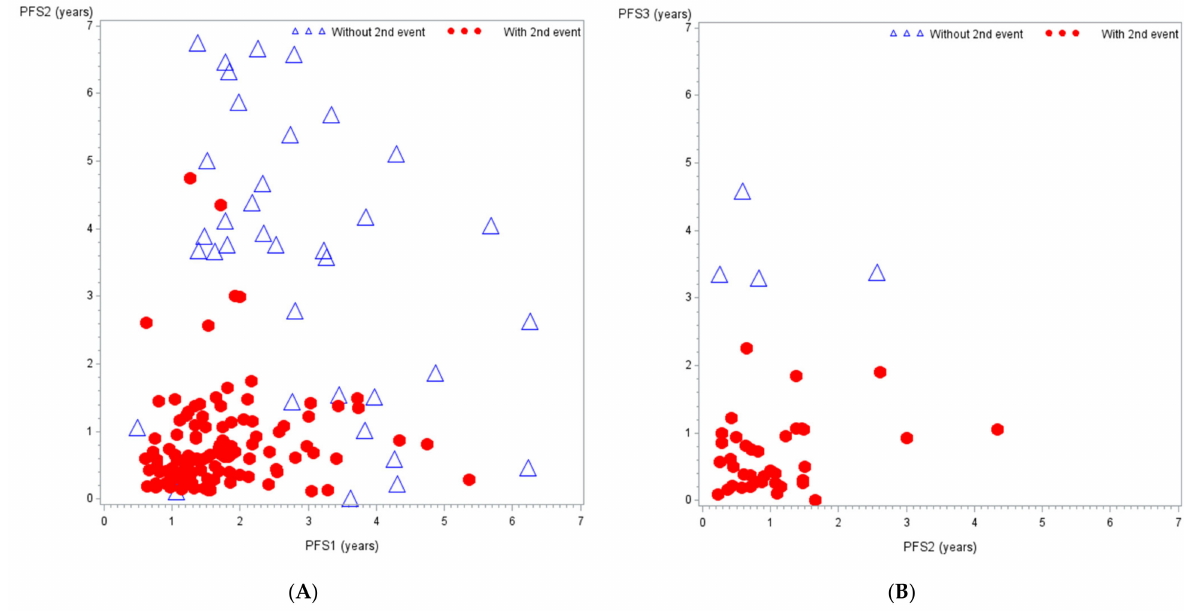
Figure 3. Correlation between successive PFS. ( A ). Correlation between PFS2 and PFS1. Kendall’s Tau coefficient = 0.163 (95%CI, 0.043–0.28). GMI > 1.3 = 23.2% (se = 3.6%). ( B ). Correlation between PFS3 and PFS2. Kendall’s Tau coefficient = 0.088 (95%CI, − 0.17–0.33). GMI > 1.3 = 28.6% (se = 8.0%). Blue triangle: without a second event—Red dot: with a second